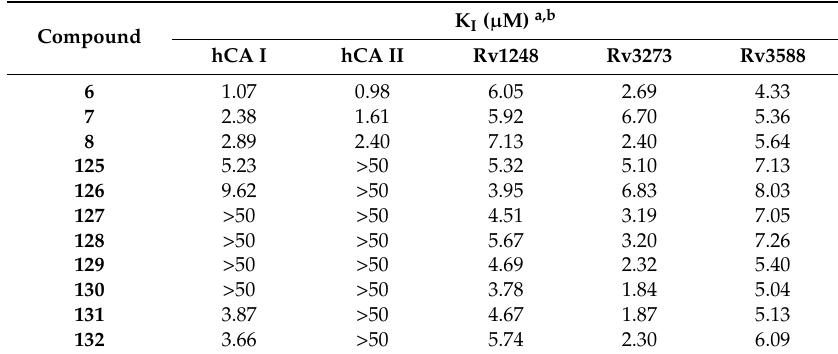
Table 13. Inhibition of human CA isozymes I and II and Mtb CAs Rv1248, Rv3273 and with phenolic acids 6 – 8 and esters 122 – 129 by a stopped flow CO 2 hydrase assay.